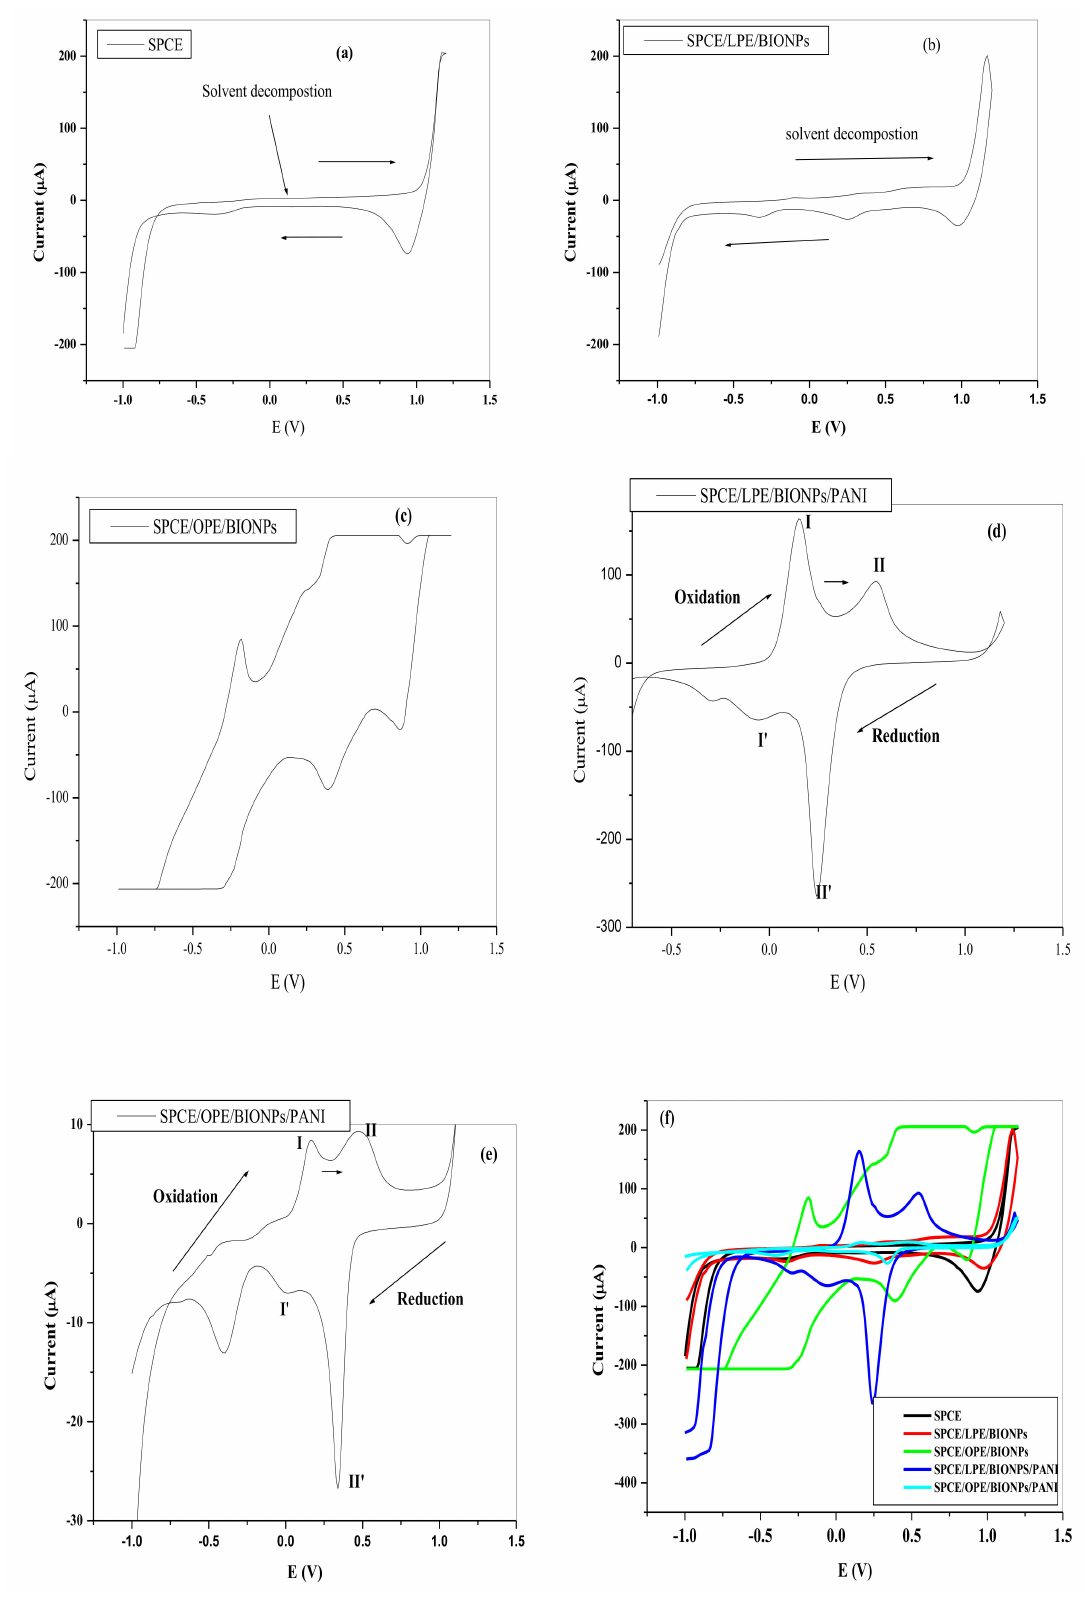
Figure 8. The CV of the ( a ) SPCE ( b ) SPCE/LPE/BiONPS ( c ) SPCE/OPE/BiONPs ( d ) SPCE/LPE/BiONPs/PANI ( e ) SPCE/OPE/BiONPs/PANI and ( f ) Comparative voltamogram of the electrodes in 0.1 M HCl, (scan rate = 0.1 V/s, pH = 1.0, Potentials vs.